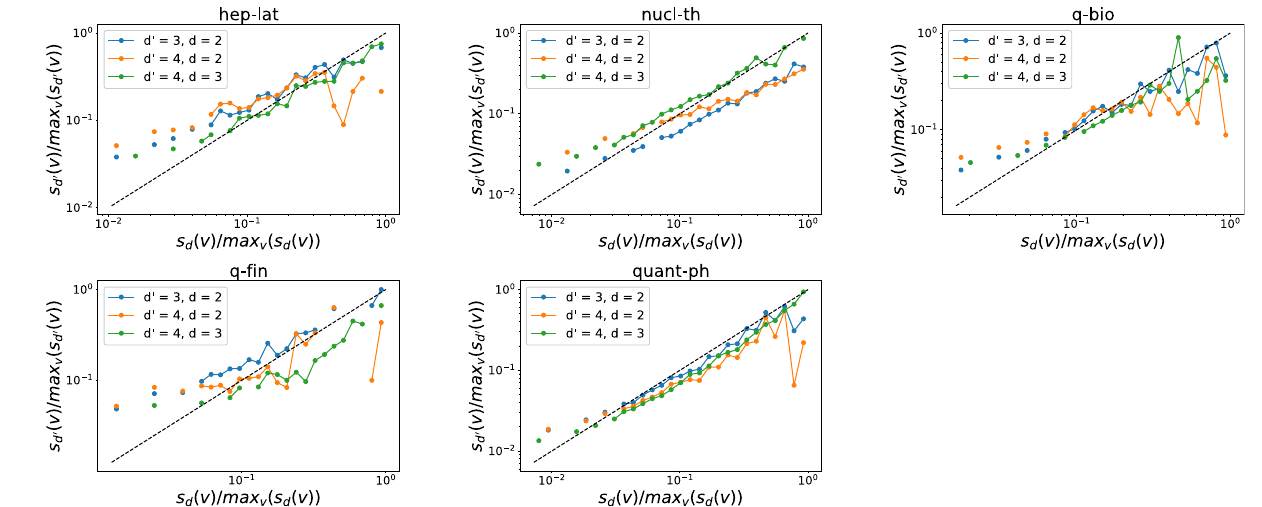
Figure 8. The d ′ -strength s d ′ ( v ) versus the the d -strength s d ( v ) of a node v when ( d ′ , d ) is equal to (3,2) (blue line), (4,2) (yellow line) and (4,3) (green line) respectively in each collaboration network. Each axis (e.g., s d ( v ) ) has been normalized by its maximum (e.g., max v ( s d ( v )) ). Only nodes whose d -strength and d ′ -strength are both non-zero are considered. The dashed line represent the reference case